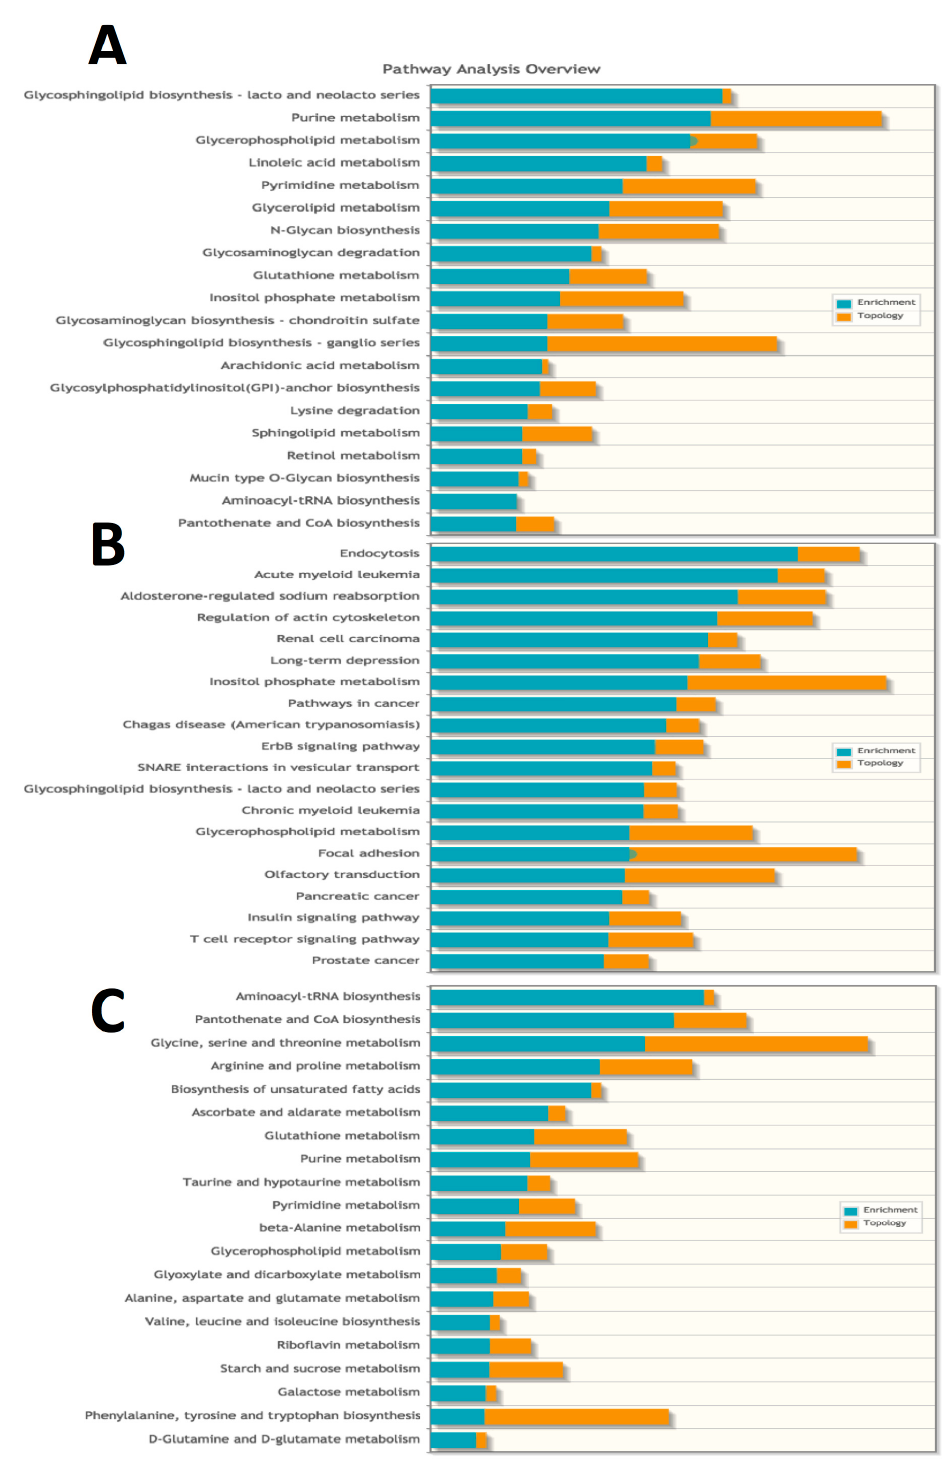
Figure 6. Integrated enrichment analysis using multi-‘omics datasets from livers of spaceflight mice compared with AEM ground controls. Data were submitted to the MetaboAnalyst Integrated Pathway Analysis module. ( A ) gene-metabolite; ( B ) gene and ( C ) metabolite centric workflows were compared for n = 6 mice per group.